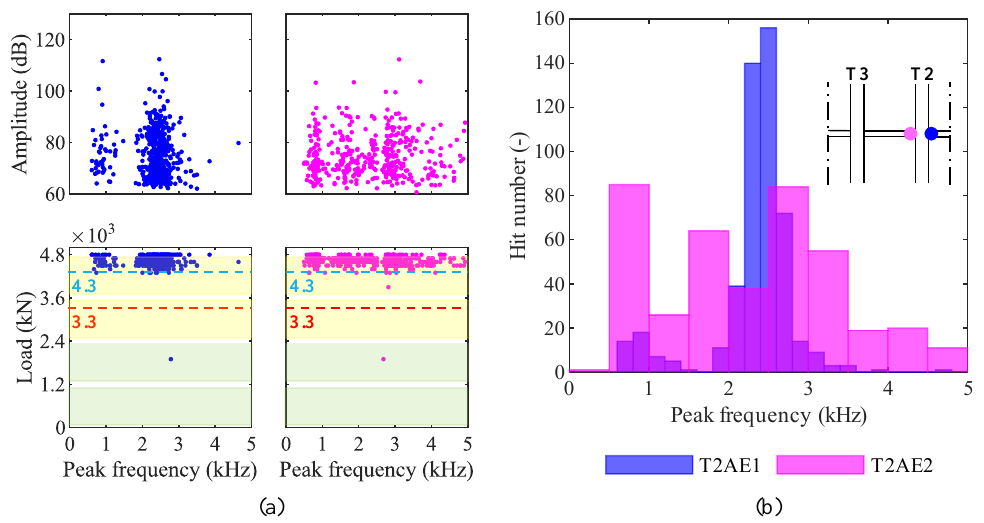
Figure 13. Results in the time-domain from the loading phase P3 4800 kN: ( a ) amplitude; ( b ) cumulative number of hits; ( c ) signal strength; and ( d ) cumulative signal strength.